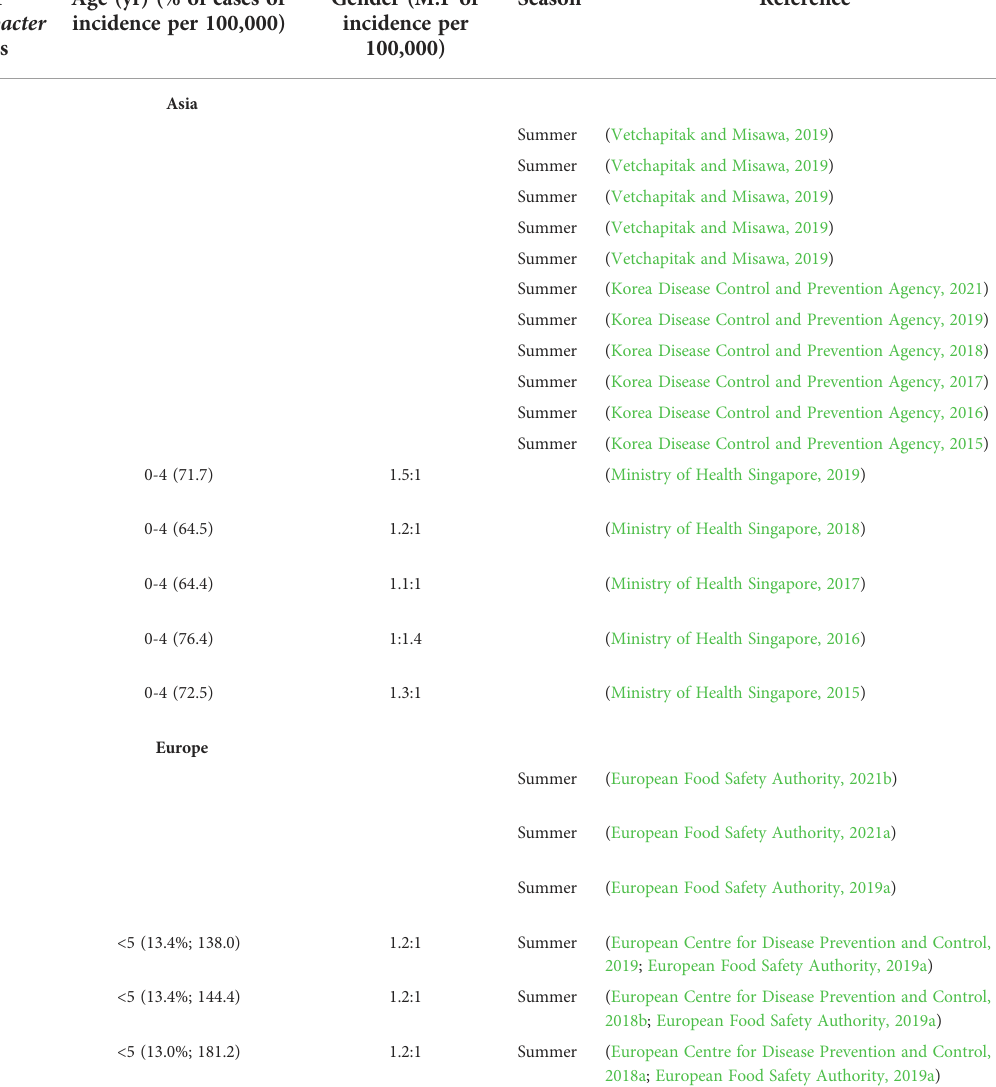
TABLE 1 Incidence and national case numbers of campylobacteriosis between 2014-2021 in countries with national surveillance.